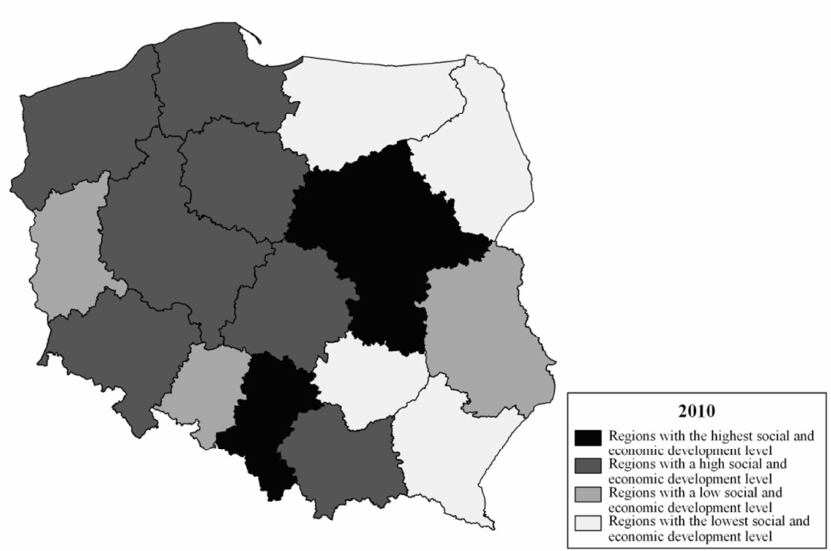
Source: own study on the basis of data from Table 2. Figure 2. The social and economic development level of Polish regions in 2015